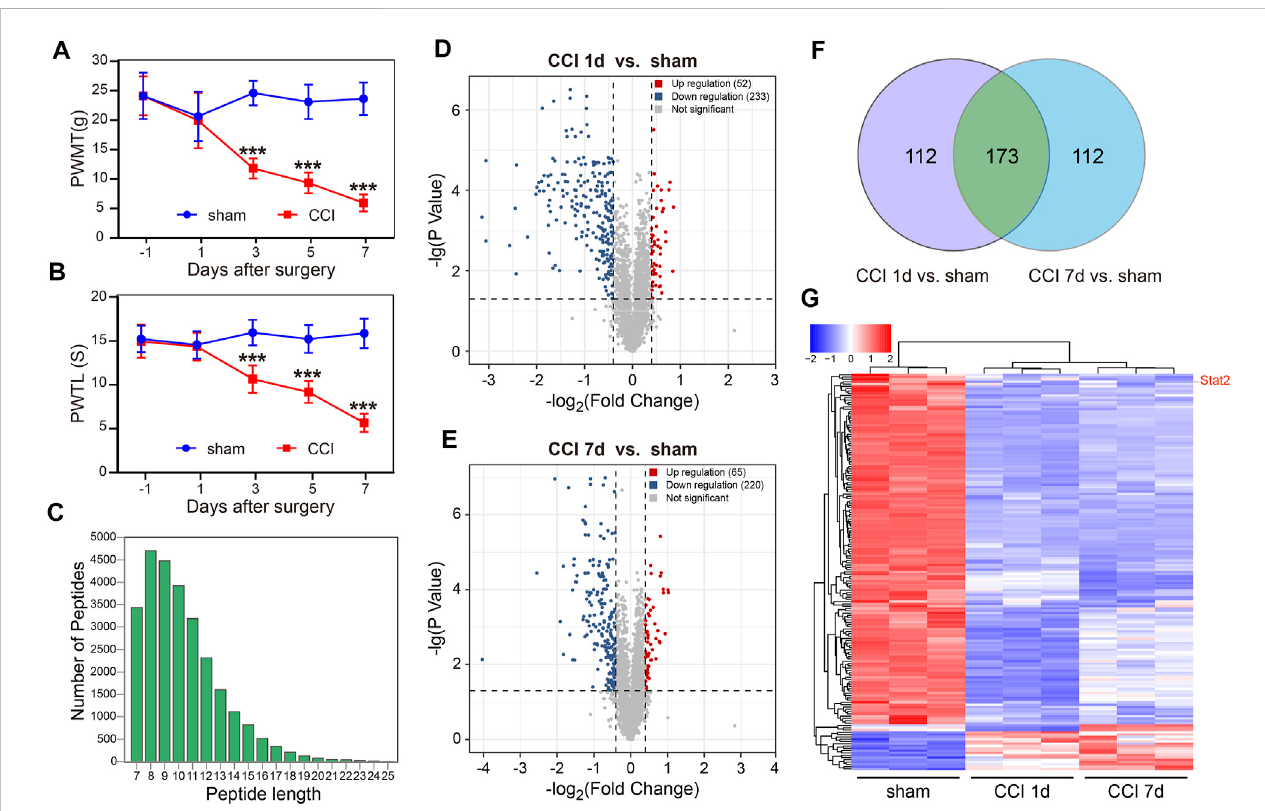
FIGURE 1 Global differentially expressed proteins (DEPs) in the spinal dorsal horn (SDH) of rats following chronic constriction injury (CCI). Rats developed neuropathic pain after CCI surgery, as evidenced by the decrease in the paw withdrawal mechanical threshold (PWMT) (A) and the paw withdrawal thermal latency (PWTL) (B) ( n = 8, *** p < .001, two-way ANOVA with repeated measures followed by Bonferroni ’ s multiple comparisons test). (C) The quality control results of mass spectrometry data. The horizontal coordinate indicates the peptide length, and the vertical coordinate indicates the number of peptides. (D) Asigni fi cantdifferenceinnuclearproteinswasfoundbetweentheshamandCCIgroupsonday1. (E) Asigni fi cantdifferenceinnuclearproteinswasfound between the sham and CCI groups on day 7. The horizontal coordinate represents the log2 value (Fold Change), and the vertical coordinate represents − lg ( p -value). Upregulated genes are shown in red, downregulated genes are shown in blue, and genes with no signi fi cant differences are shown in gray. (F) The unique or shared DEPs in each of the paired groups. (G) The differences in 173 nuclear proteins at 1 and 7 days after CCI compared with those in the sham